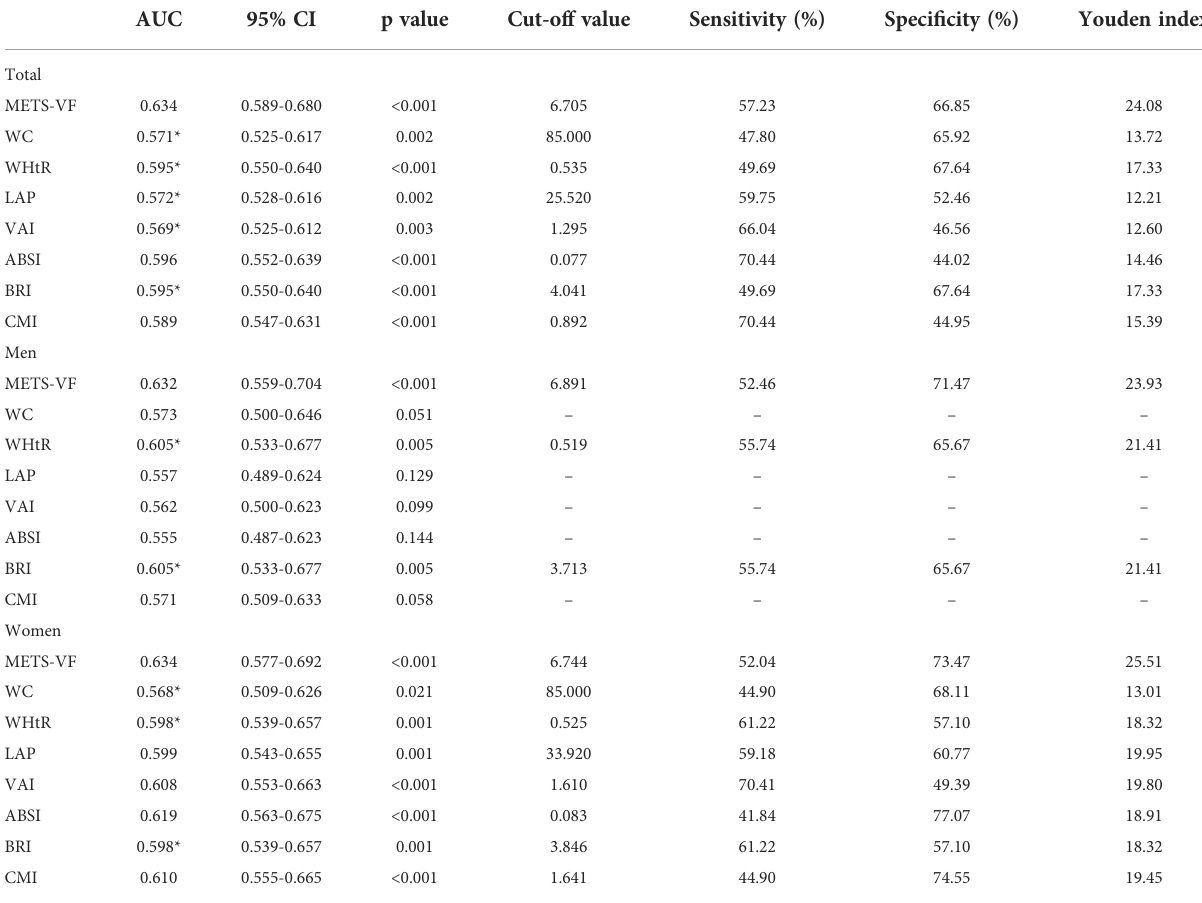
TABLE 4 ROC analyses for the prediction of CKD by adiposity